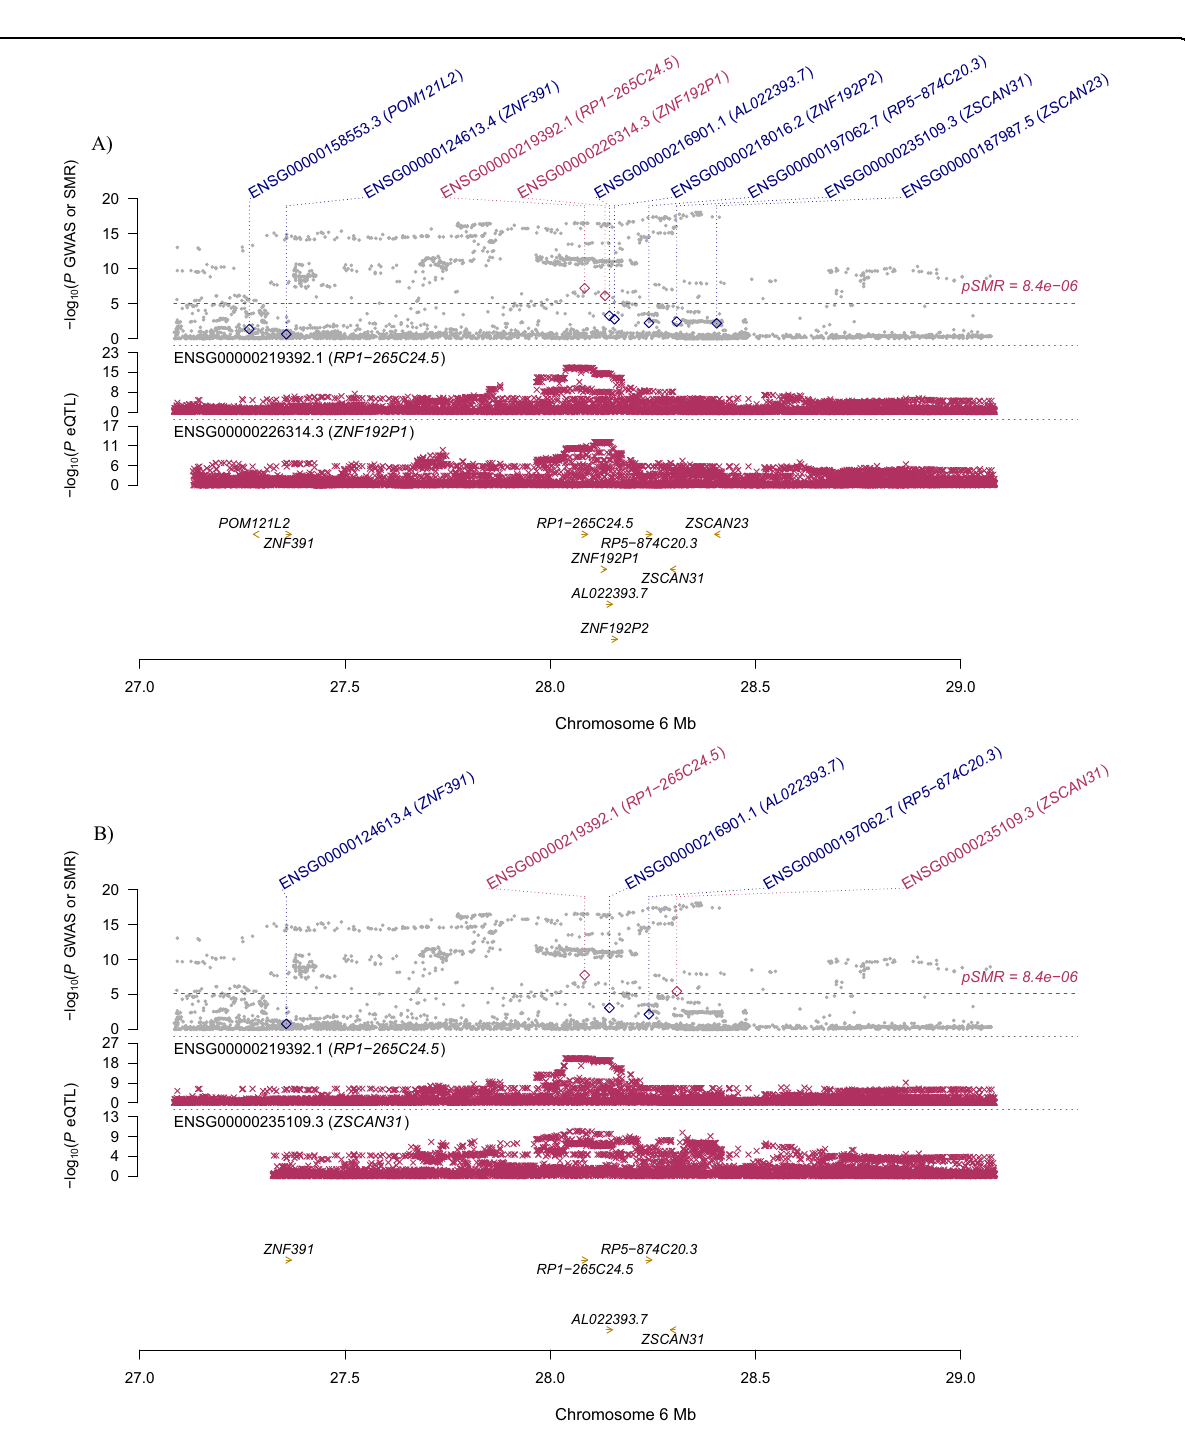
Fig. 3 Prioritizing genes around RP1-265C24.5 in pleiotropic association with MDD. A Cortex. B Nucleus accumbens. Top plot, gray dots represent the − log 10 ( P values) for SNPs from the GWAS of MDD, and rhombuses represent the − log 10 ( P values) for probes from the SMR test with solid rhombuses indicating that the probes pass HEIDI test and hollow rhombuses indicating that the probes do not pass the HEIDI test. Middle plot, eQTL results for the probe ENSG00000219392.1 tagging RP1-265C24.5 . Bottom plot, location of genes tagged by the probe. Highlighted in maroon indicates probes that pass the SMR threshold. GWAS genome-wide association studies, MDD major depressive disorder, SMR summary data-based Mendelian randomization, HEIDI heterogeneity in dependent instruments, eQTL expression quantitative trait